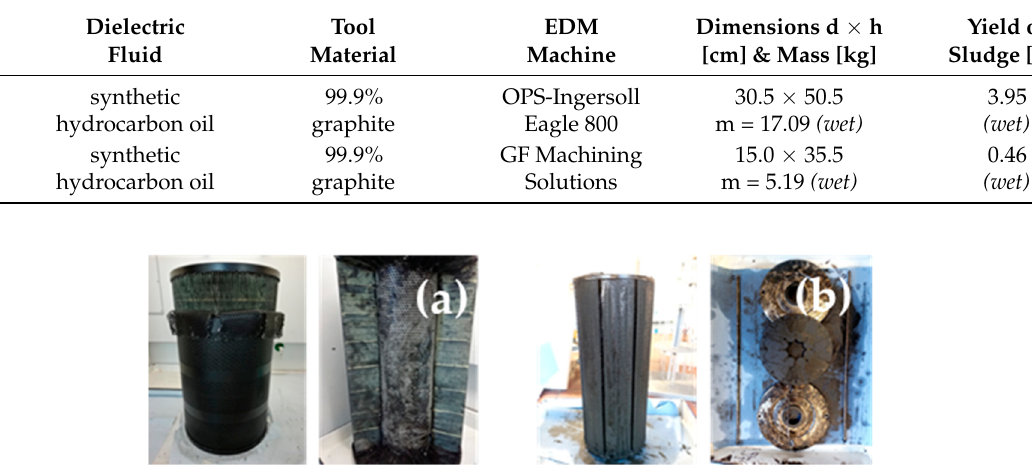
Figure 3. Investigated filter cartridges, left: ( a ) SE_01-MT, right: ( b ) SE_02-AP.